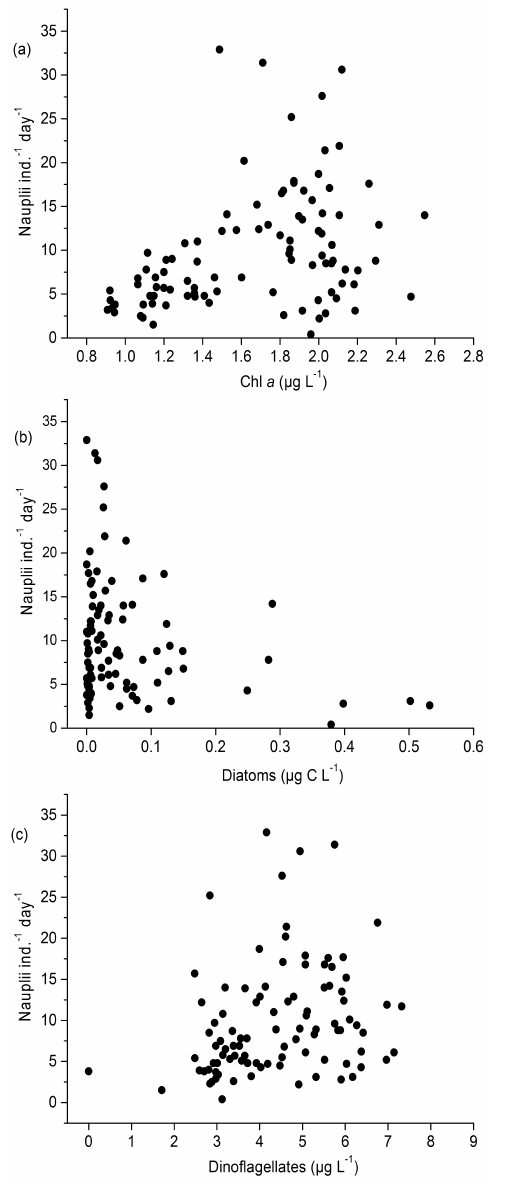
Figure 2. Daily nauplii production of E. affinis as a function of (a) Chl a concentration, (b) diatom biomass, and (c) dinoflagellate biomass.